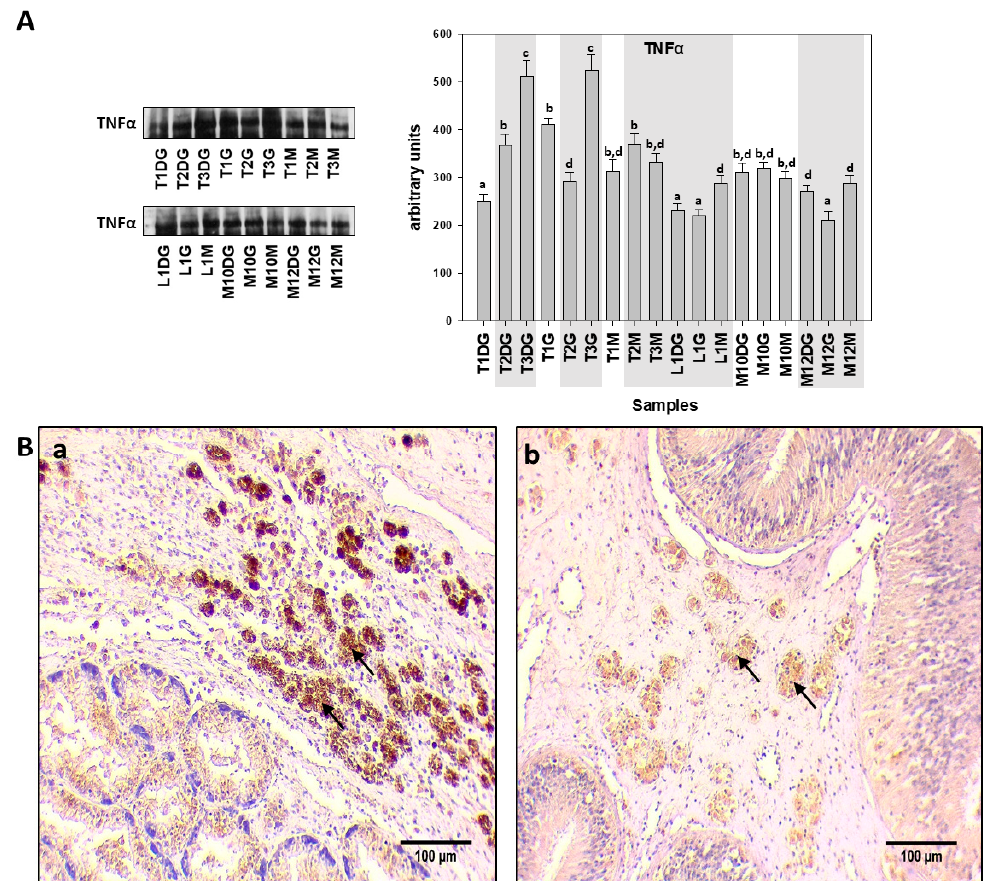
Figure 5. ( A ). TNF α levels in the digestive gland (DG), gills (G), and mantle (M) of Pinna nobilis specimens from Kalloni Gulf (Lesvos Island) (M10, M12), from Thermaikos Gulf (Thessaloniki) (T01, T02, T03), and from Limnos Island (L1). All specimens were infected with mycobacteria and vibrios, while grey shaded areas represent specimens additionally in- fected with the haplosporidian parasite. Tissue extracts from all groups were immunoblotted for TNF α . Blots were quan- tified using scanning densitometry. Representative blots are shown. Lower case letters indicate statistically significant differences ( p < 0.05) between samples. ( B ). (a,b) Immunohistochemical detection (arrows) of TNFa, in the connective tissue of P. nobilis digestive gland of non-infected (a) and infected (b) specimens by H. pinnae